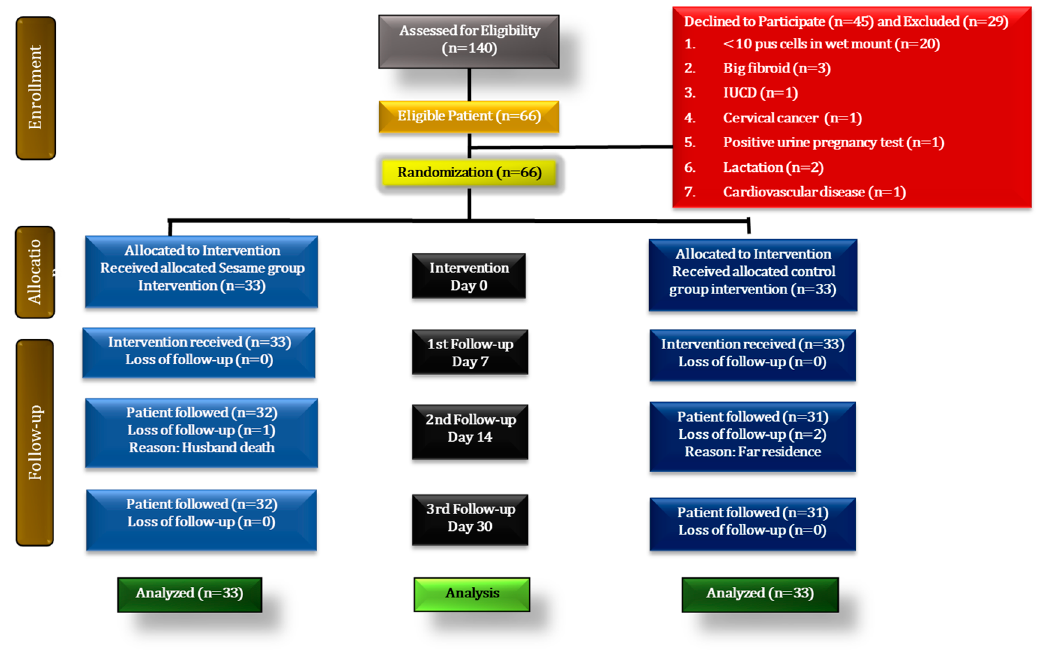
Figure 1. Consort statement for enrolment of participants.